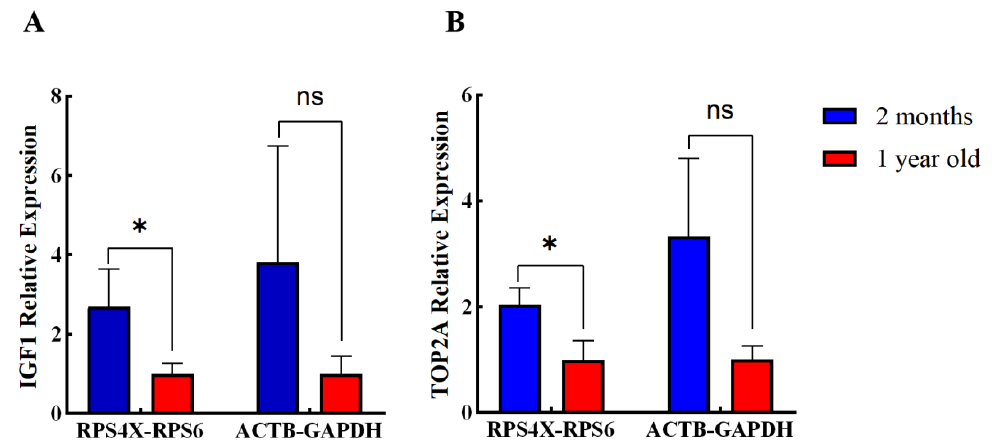
Figure 4. The relative expressions of IGF1 ( A ) and TOP2A ( B ) normalized to the different RGs combinations (the most stable RPS4X and RPS6 , and the least stable GAPDH and ACTB ) using rumen tissues sampled at two developmental stages. * p < 0.05. “ ns ” means no significant difference between the two groups.